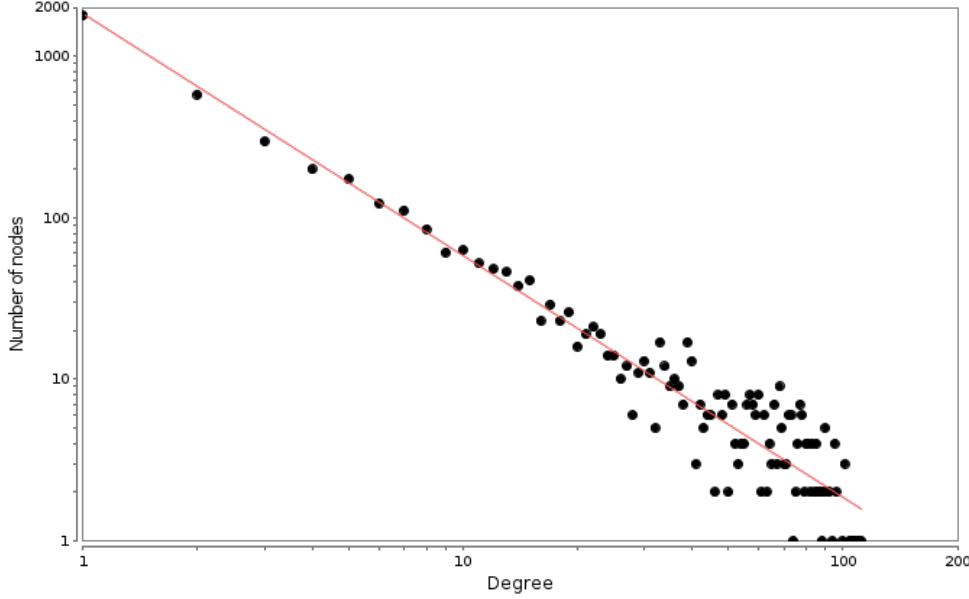
Figure 2. PCN degree distribution plot. Each point represents the number of proteins (Y axis) that have a given number of neighbors (X axis). The red line is the power law fitting with an exponent α = −